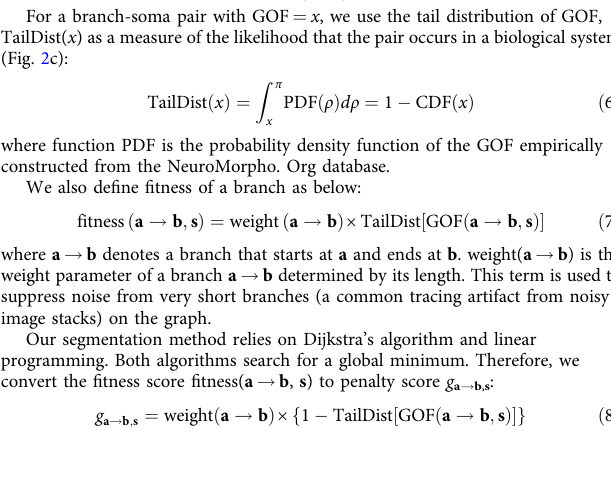
Table 1 Mathematical symbols and their